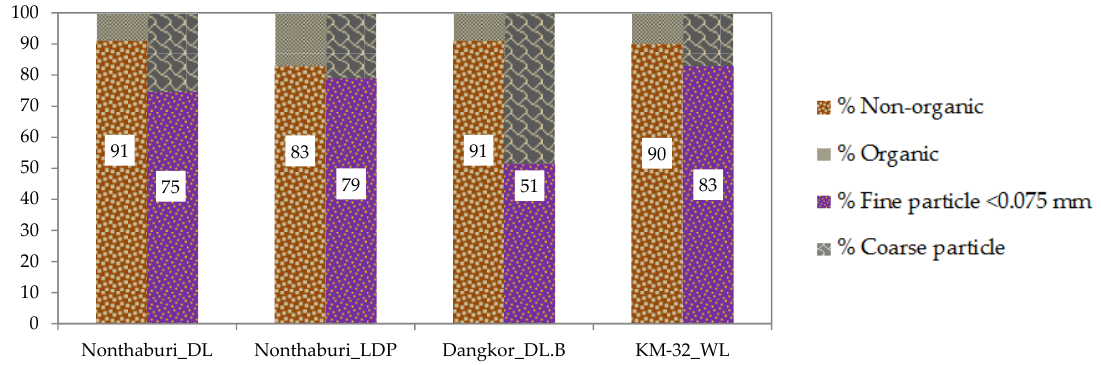
Figure 14. Organic and non-organic fraction and fine and coarse particle fractions of the sediments.